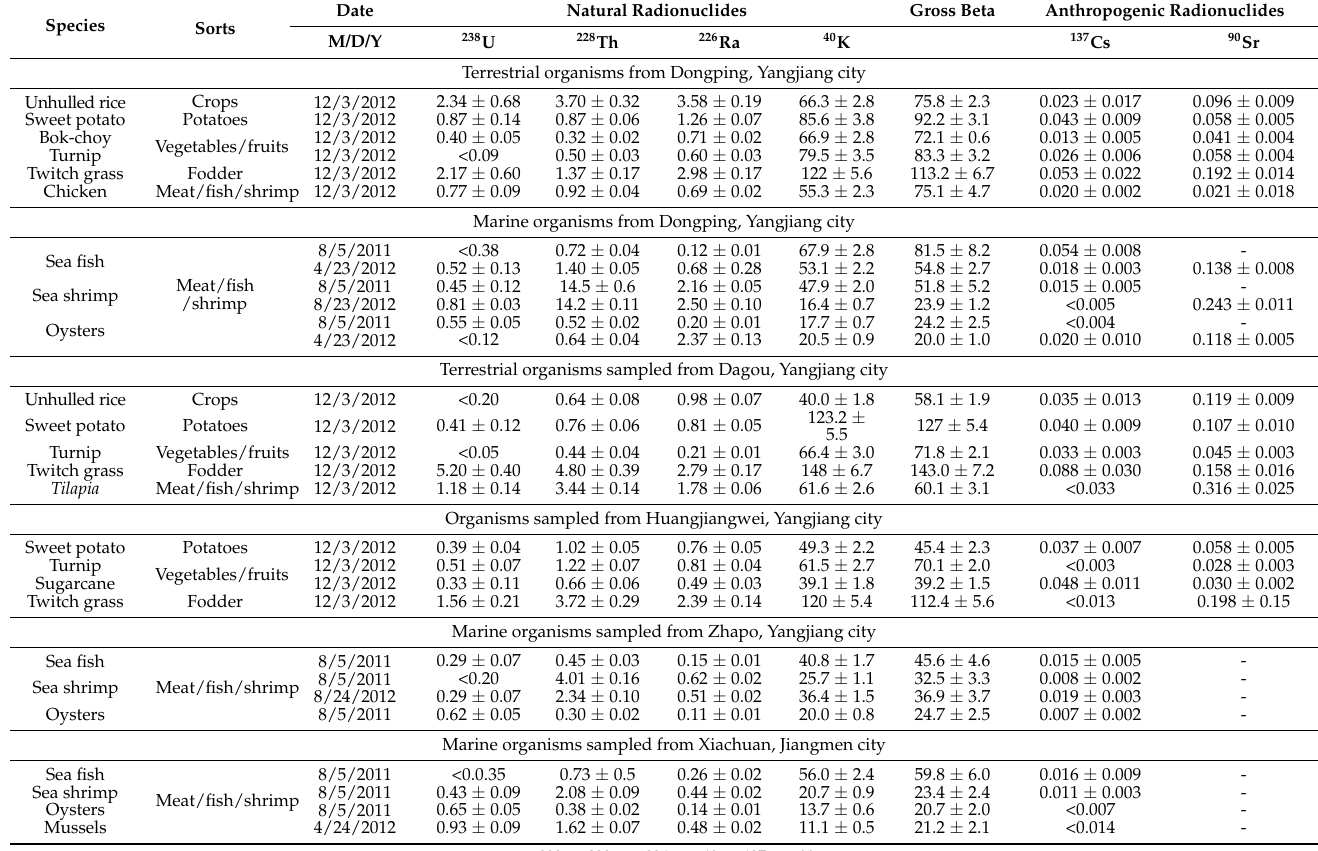
Table 1. 238 U, 228 Th, 226 Ra, 40 K, gross beta, 137 Cs, 90 Sr in the organisms from Yangjiang and the adjacent